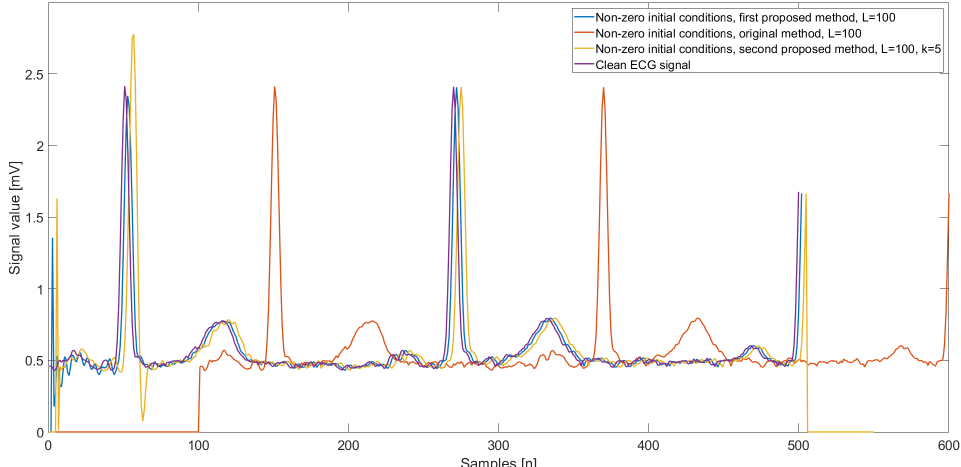
Figure 5. Filtering results of the ECG signal using different methods of determining non-zero initial